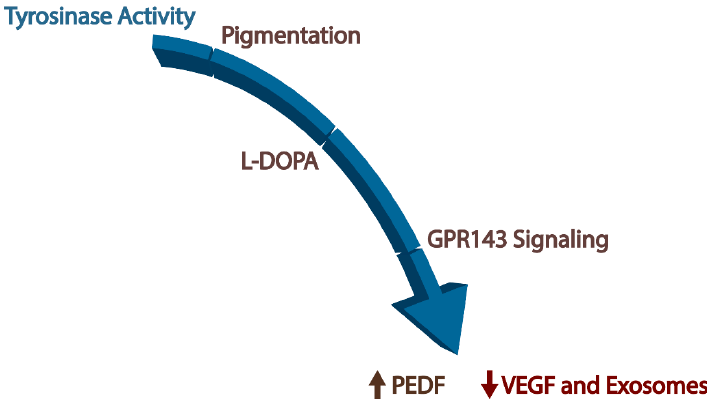
Figure 5. Schematic diagram of the path from tyrosinase activity in the retinal pigment epithelium to increased pigment epithelium-derived factor (PEDF) secretion, decreased secretion of